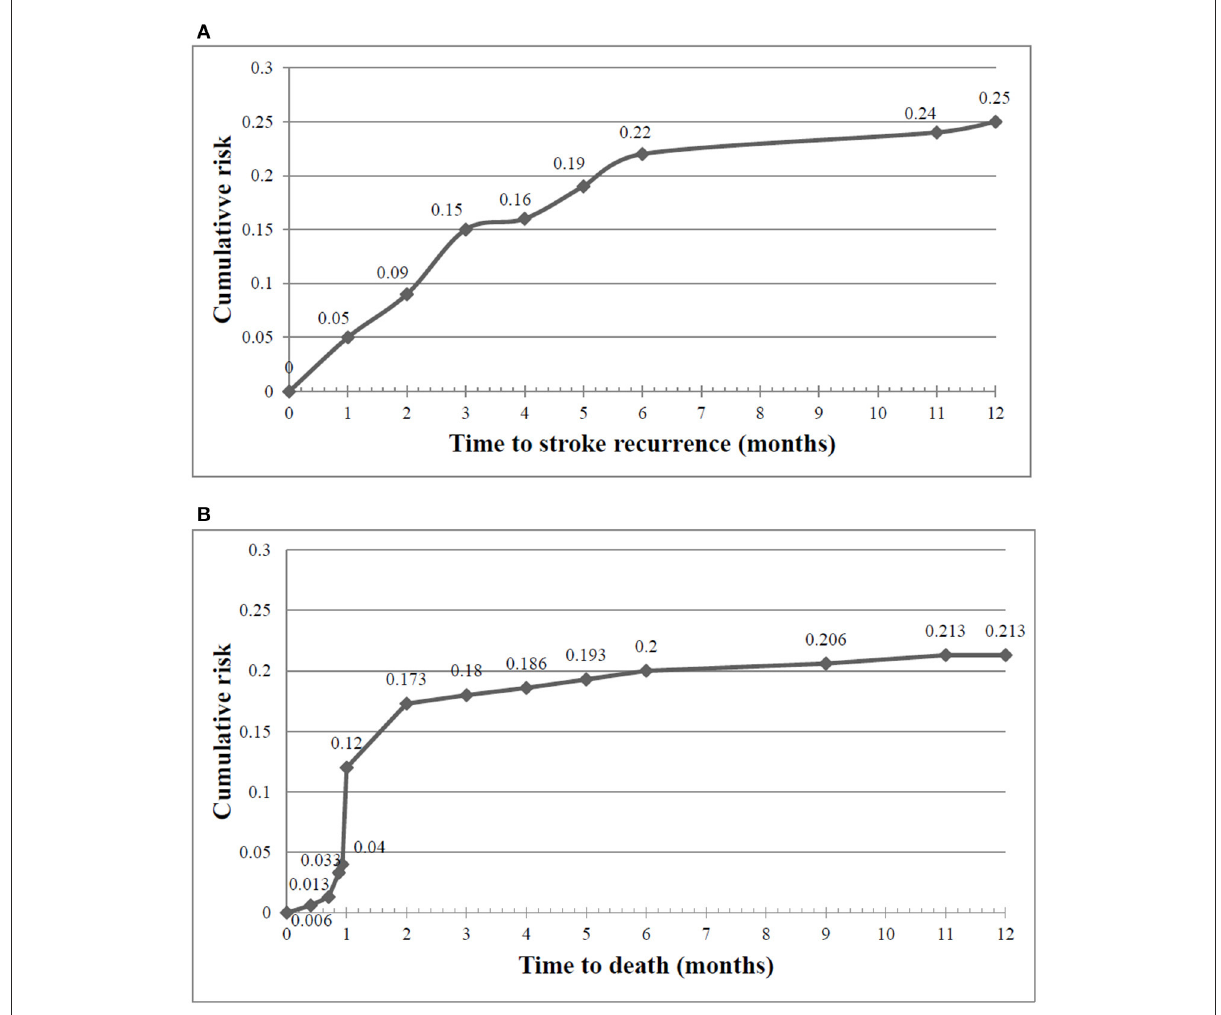
FIGURE4 Cumulative risk rates of stroke recurrence (A) and any-cause of death (B) at 3, 6, and 12 month post-stroke.